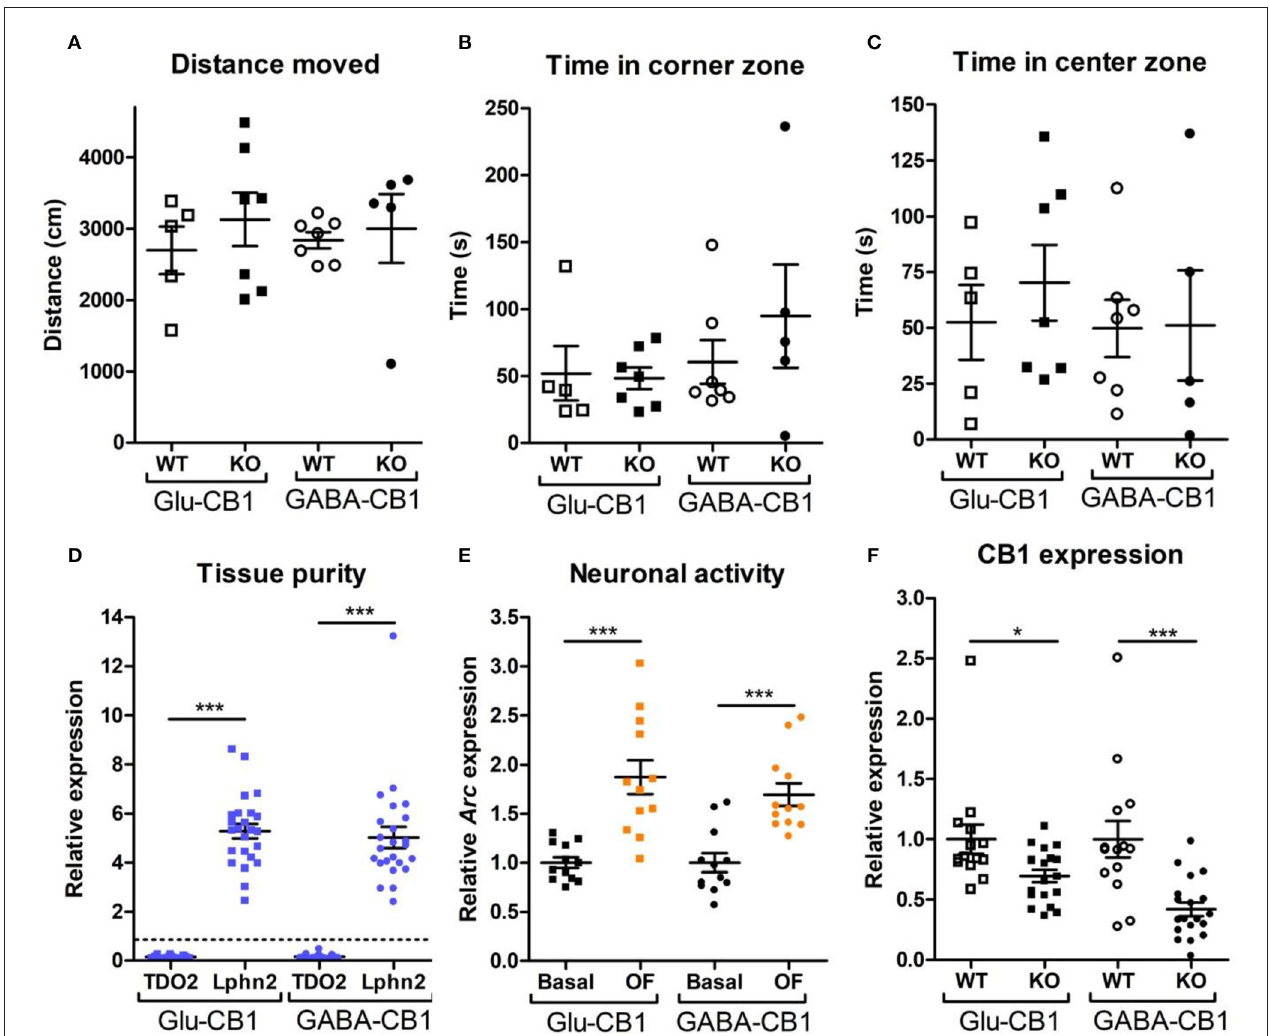
FIGURE 1 | Behavioral and qPCR data used for the selection of the final samples. Samples for RNA-sequencing were selected depending on the purity of the dissected tissue, as well as the anxiety-like behavior and the neuronal activity induced by the exposure to the open field. All animals that are shown were selected for the transcriptomic analysis. (A) Locomotion activity in the open field arena (statistical power = 9.06%; calculated by one-way ANOVA power analysis). (B) Time spent in the corner zones (anxiety-like behavior) of the open field arena (statistical power = 7.92%; calculated by one-way ANOVA power analysis). (C) Time spent in the center zone (anxiolytic-like behavior) of the open field arena (statistical power = 9.81%; calculated by one-way ANOVA power analysis). (D) Gene expression levels for the gene activity-regulated cytoskeleton-associated protein ( Arc ) showed increased neuronal activity upon brief exposure to a new environment (open field arena). CB1-WT and their respective conditional CB1-KO samples were pooled together in each of the groups shown. (E) The purity of the tissue resulting from the microdissection of the hippocampus was checked by measuring the expression levels of tryptophan 2,3-deoxygenase ( TDO2 ) and latrophilin 2 ( Lphn2 ), which are specific for the DG and the CA. The graph shows only CA tissue samples that were normalized and compared to the respective DG samples (dashed line). (F) Gene expression levels of CB1 ( cnr1 ) in the CA regions of CB1-WT mice and the respective conditional CB1-KO animals. Samples from basal state and open field group were pooled together. Bars represent mean ± S.E.M. Unpaired t -Test with Welch’s correction when variances between groups were different. * p < 0.01; *** p < 0.001.